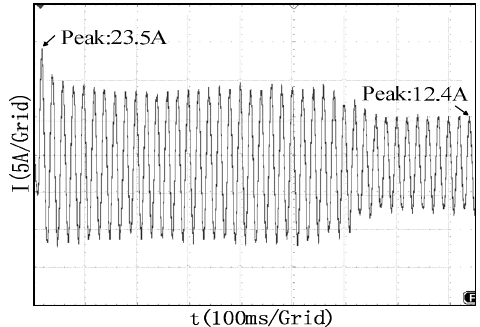
Figure 18. Test waveforms of the phase current of the stator winding in asynchronous mode.